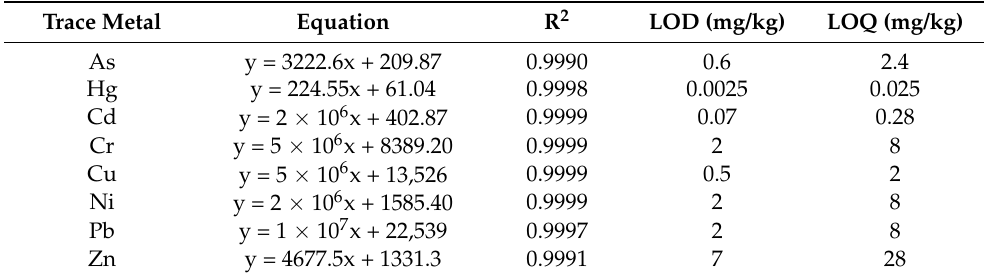
Table A3. Results of the linear relationship between the trace metals (fish and sediment).